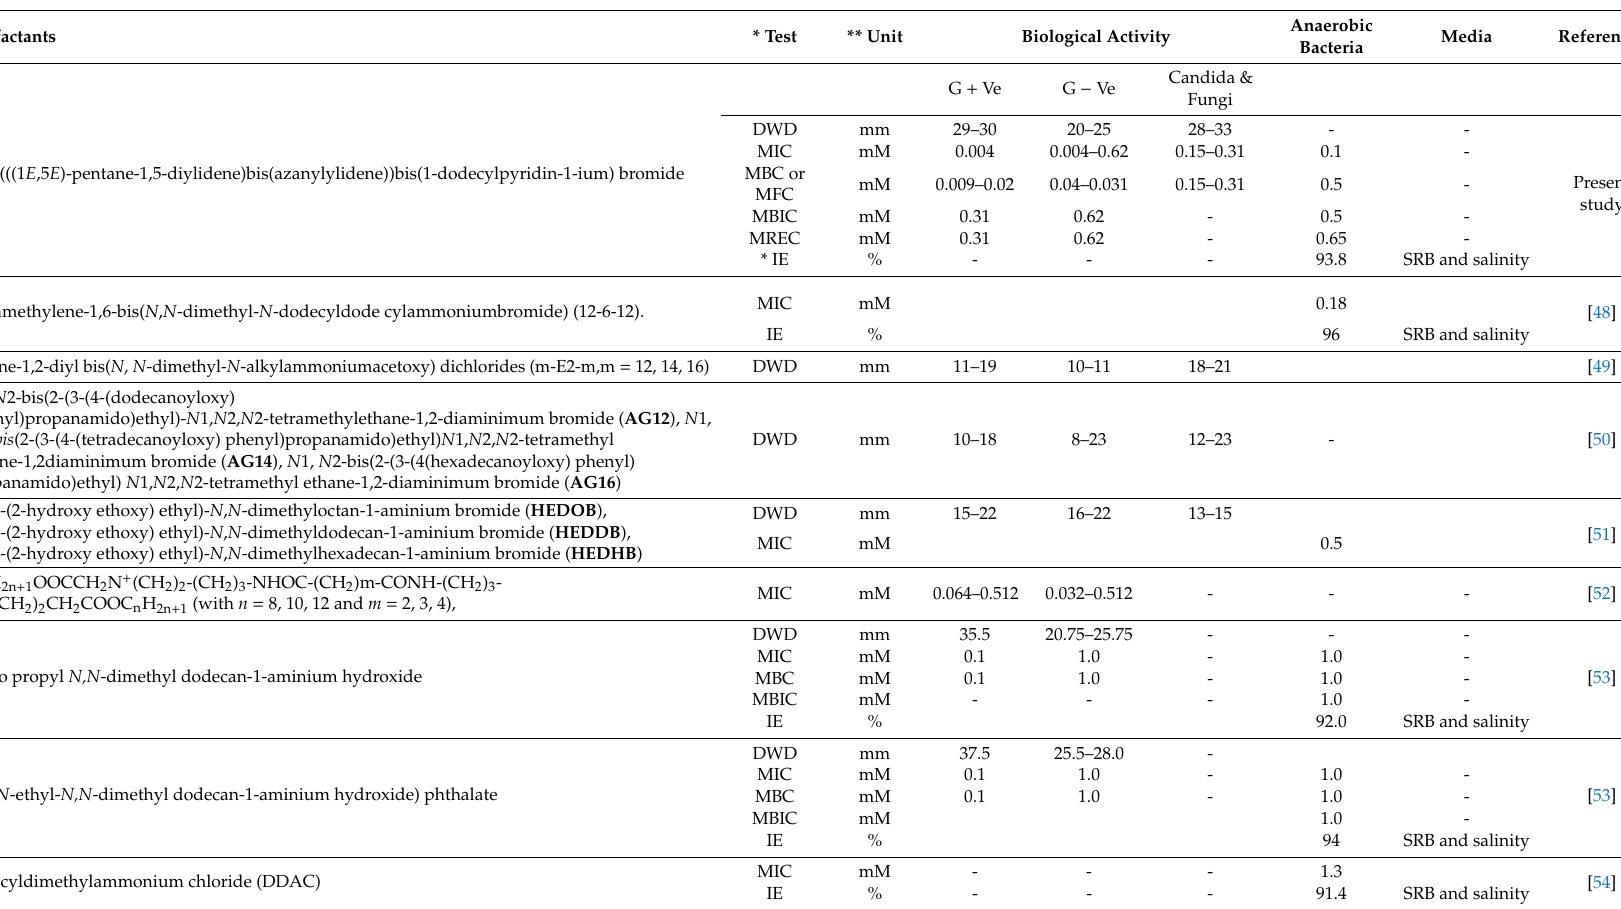
Table 6. Comparison of the biological activity and the corrosion inhibition e ffi ciency between the synthesized surfactant and the other published synthesized surfactants.